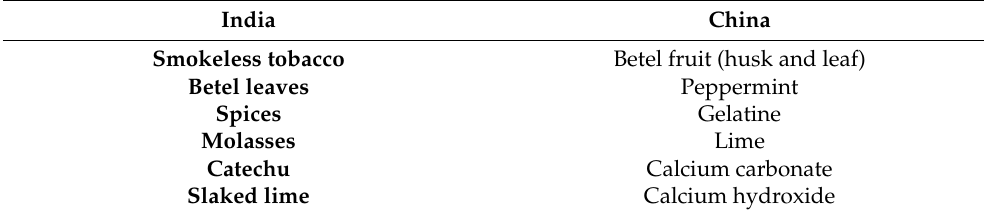
Table 3. Examples of common ingredients most likely to be used together with the areca nut before they are chewed; the ingredients are used in varying quantities